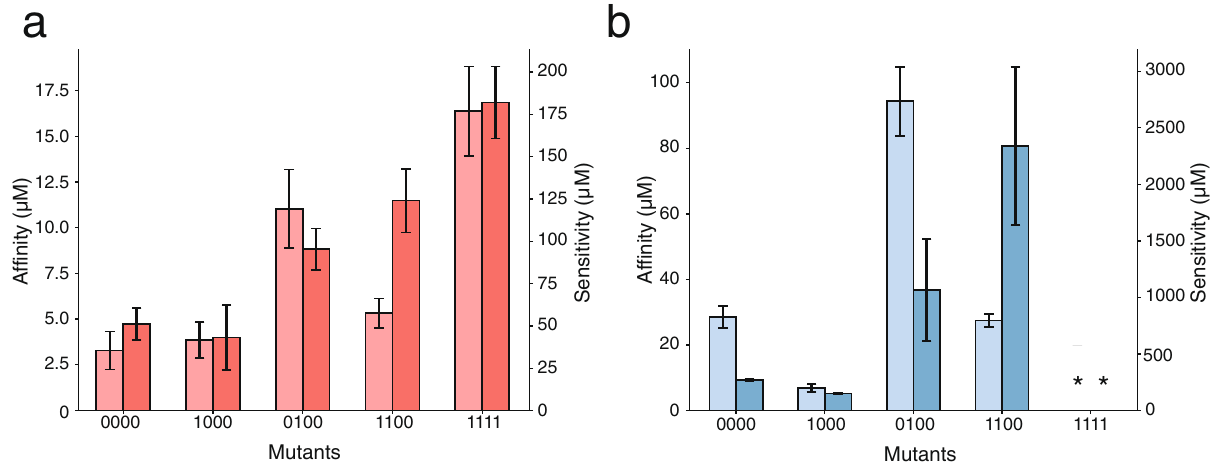
Fig. 5 Comparison of biophysical and biological properties of TtgR variants. Ligand af fi nity (light bar) and EC 50 sensitivity (dark bar) for resveratrol ( a ) and naringenin ( b ) are shown for TtgR variants 0000, 1000, 0100, 1100, and 1111. Ligand af fi nity was estimated by isothermal calorimetry and EC 50 sensitivity from fi tting dose – response curves to the Hill equation. EC 50 values and error are calculated based on fi tting to triplicate dose – response curves. ITC values and error are generated from a one-site binding model; error bars denote the error of the fi t (see methods). The values shown are likely to underestimate the actual af fi nity and sensitivity